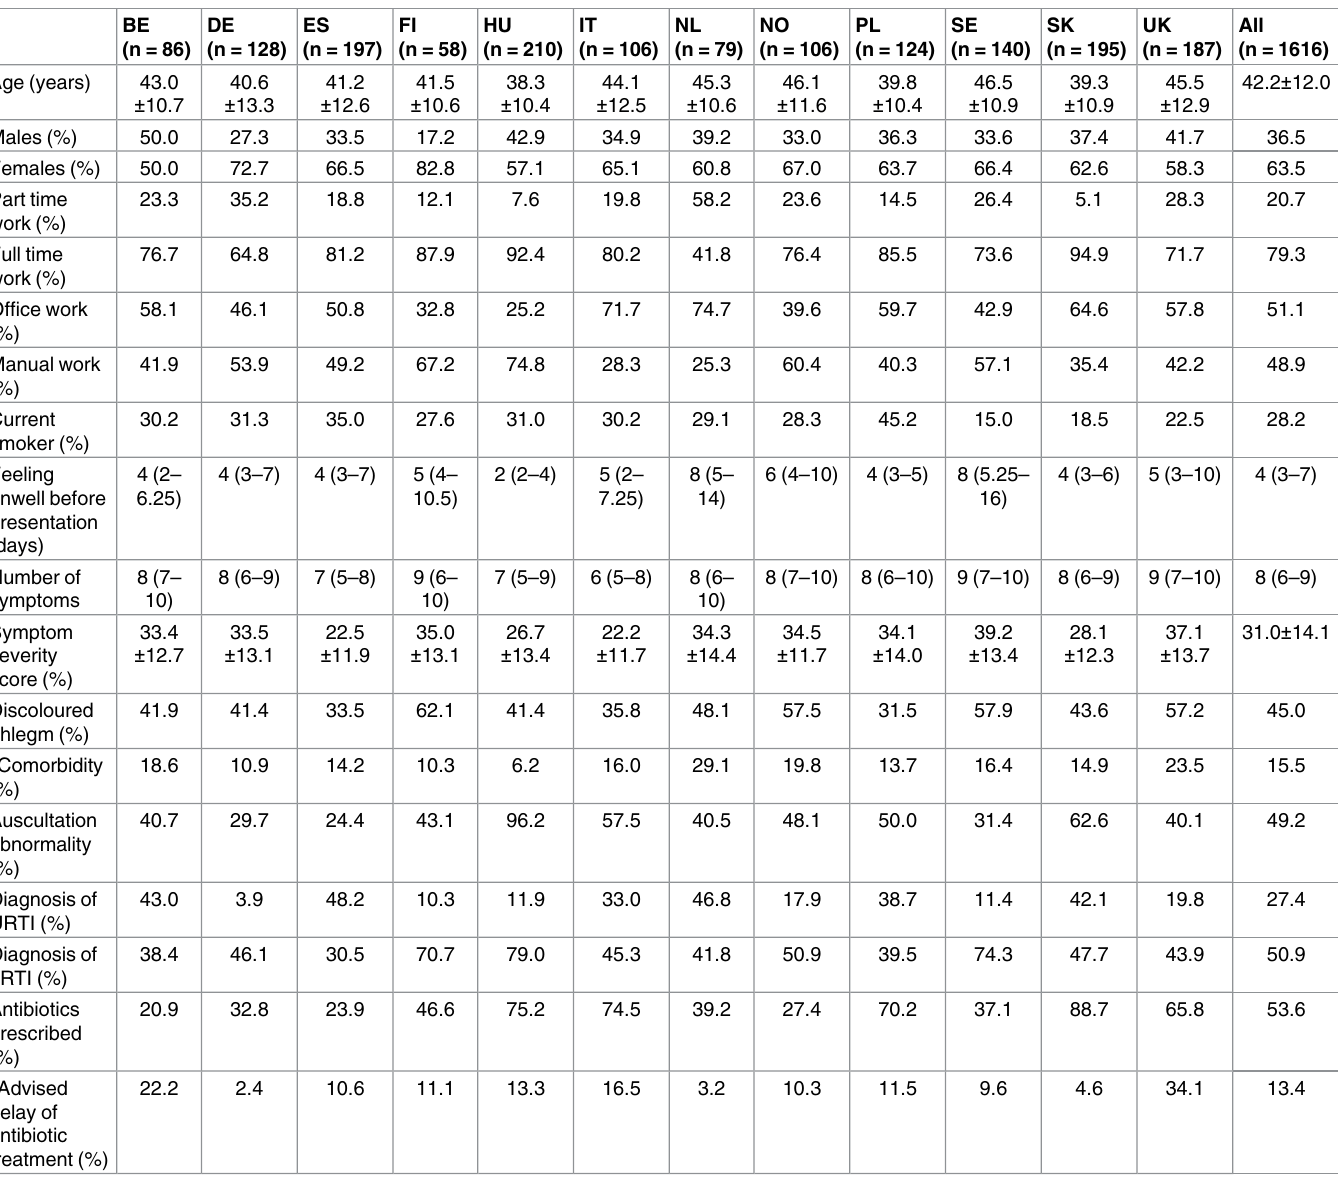
Table 1. Demographic and clinical characteristic of working patients by country of residence (network). BE—Belgium, DE—Germany, ES—Spain, FI—Finland, HU—Hungary, IT—Italy, NL—Netherlands, NO—Norway, PL—Poland, SE—Sweden, SK—Slovakia, UK—United Kingdom. Data presented as mean ± SDinflated for clustering or median(25%-75%IQR) or percentagerelated to the total number of cases in particular subgroups (%). BE DE ES FI HU IT NL NO PL SE SK UK All (n = 86) (n = 128) (n = 197) (n = 58) (n = 210) (n = 106) (n = 79) (n = 106) (n = 124) (n = 140) (n = 195) (n = 187) (n =